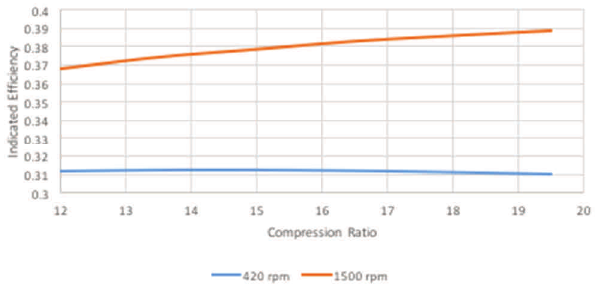
Fig. 6d: Graph of indicated efficiency against compression ratio